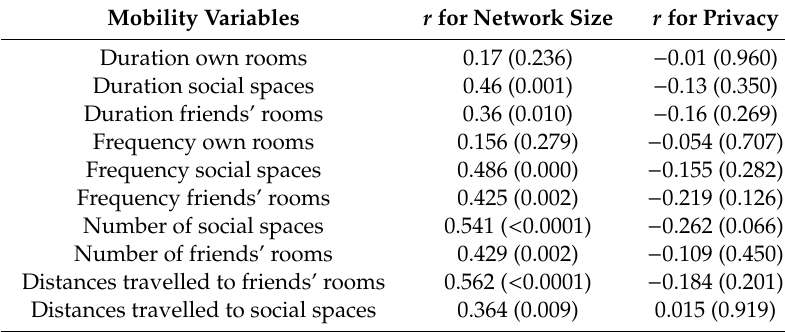
Table 4. Pearson’s correlation coe ffi cient r (and p -value) for mobility parameters versus social network size and versus di ff erent privacy levels. There is some positive correlation between mobility patterns and social relations. There is no significant correlation between privacy and mobility